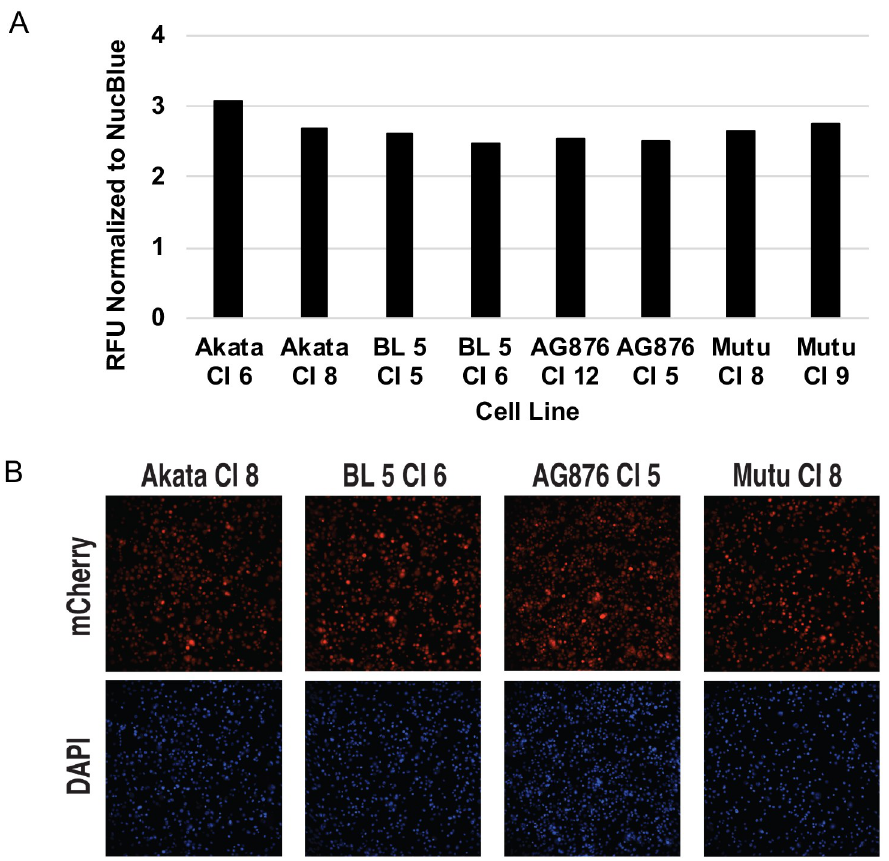
Fig 10. Calcium levels in T2 EBV-infected LCLs are similar to T1 EBV-infected LCLs. Using a fluorescent dye that increases in intensity with elevations in cellular calcium concentration, T1 and T2 LCLs were stained with the dye as described in the methods. A) Quantitative imaging analysis was performed using FIJI/ImageJ software and fluorescent intensity was normalized to the intensity of a nuclear control dye (NucBlue) as indicated. B) Representative fluorescent images for each of the different LCLs generated are shown for Calcium and